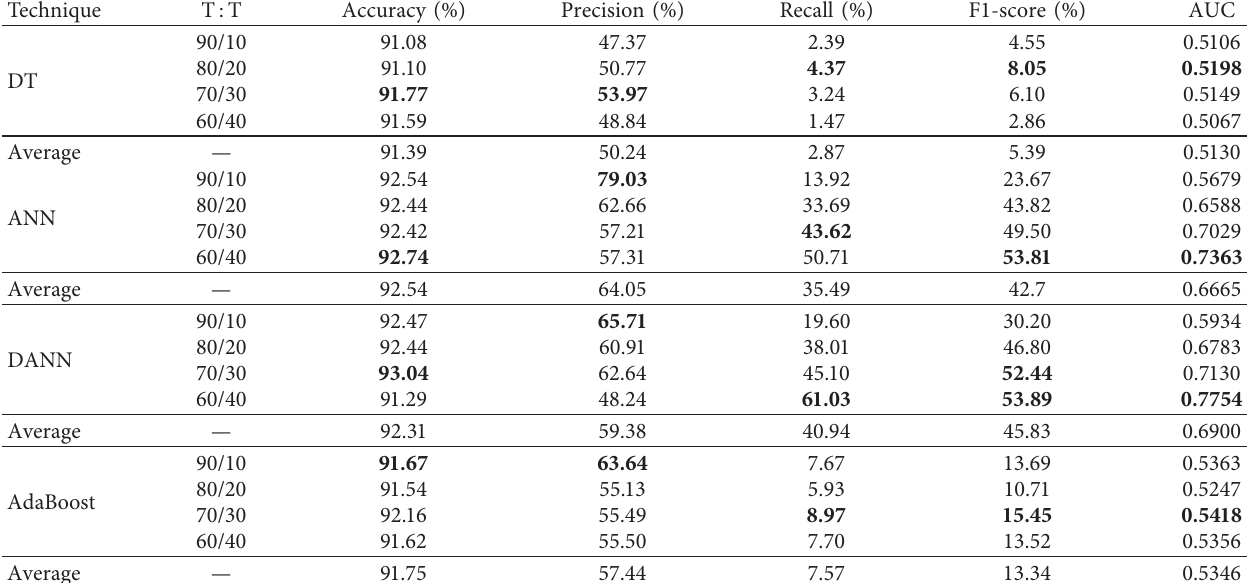
Table 3: Comparison of outcomes of supervised